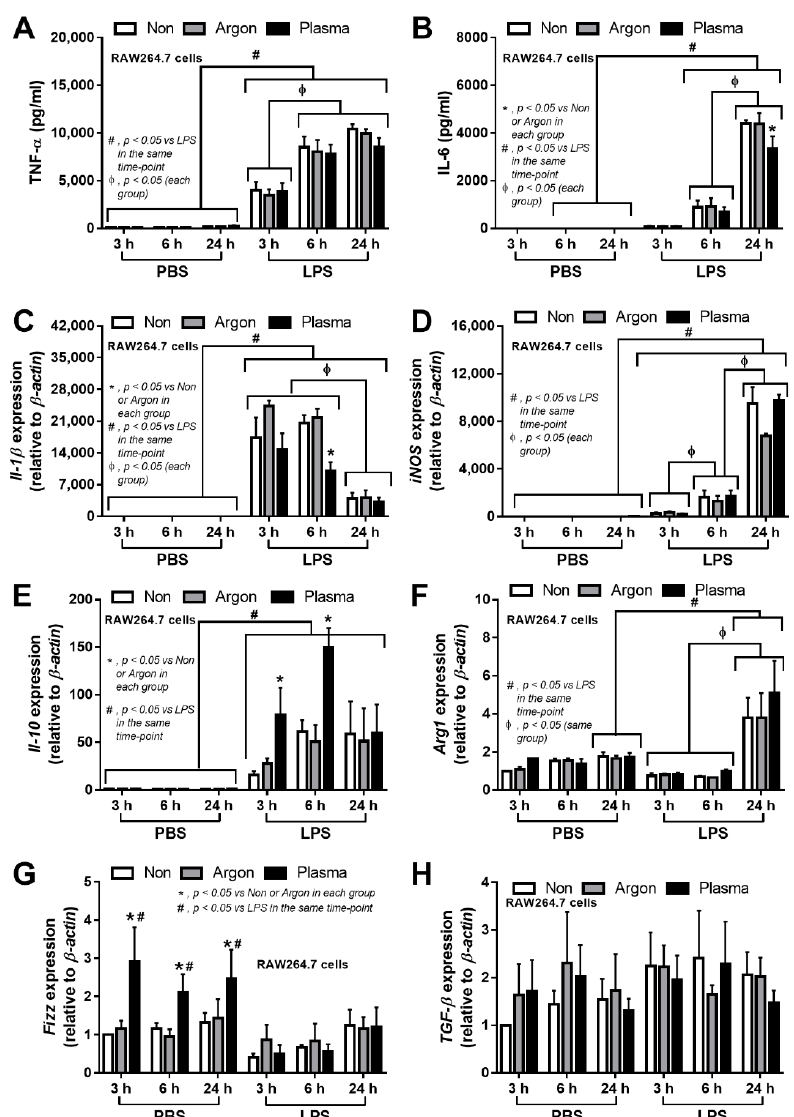
Figure 3. Responses of plasma-pretreated macrophages (RAW264.7 cells) followed by stimulation with LPS or phos- phate buffer saline (PBS) (negative control) at different time-points as evaluated by supernatant cytokines (TNF- α , IL-6) ( A , B ), gene expression of M1 macrophage polarization markers ( IL-1 β and iNOS ) ( C , D ) and M2 macrophage polarization markers ( IL-10 , Arg1 , Fizz and TGF- β ) ( E – H ) are demonstrated. Independently triplicated experiments were